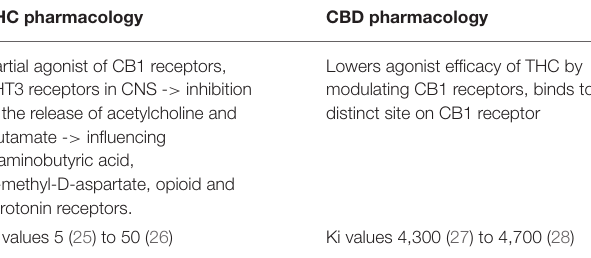
TABLE 2 | Cannabis pharmacology—THC and